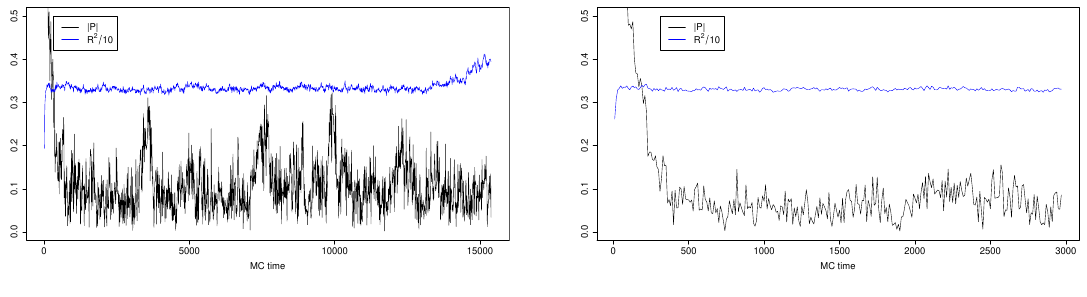
Figure 27. Monte Carlo histories from cold starts ( X 1 = X 2 = · · · = X 9 = 0 ) for µ = 0 , T = 0 . 2 , L = 48 , N = 10 (left) and N = 16 (right). For N = 10 , the onset of the run-away behavior (i.e., the increase of R 2 ) can be seen at late